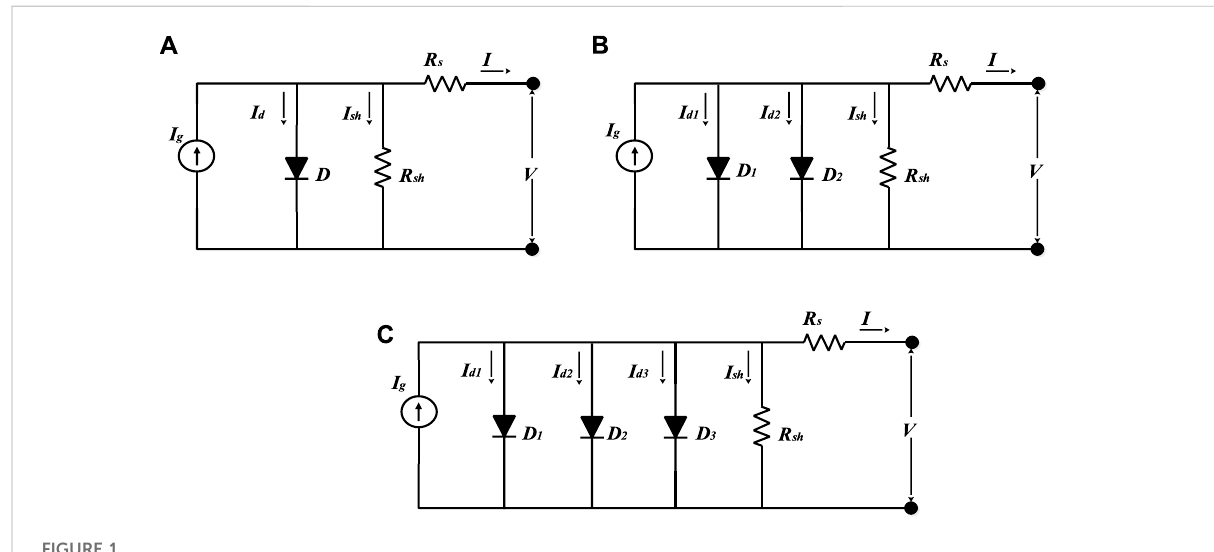
FIGURE 1 Equivalent circuits of the PV cell. (A) SDM, (B) DDM, and (C)